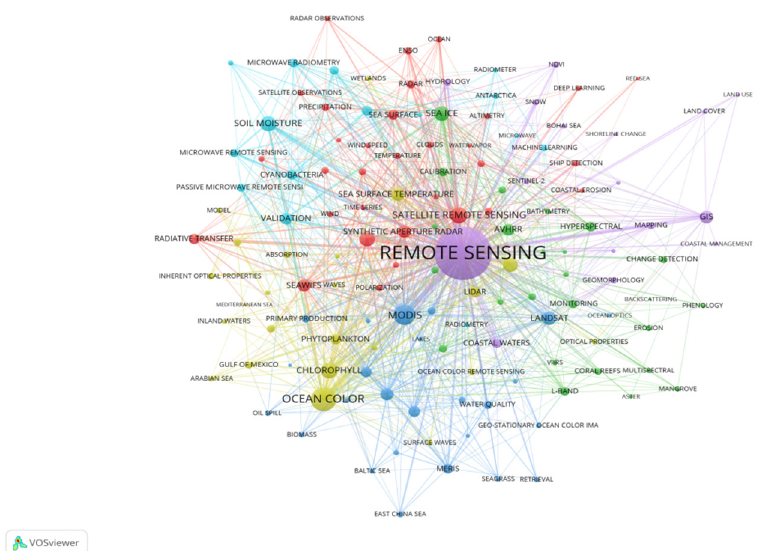
Figure 5. Co-occurrence analysis of keywords.